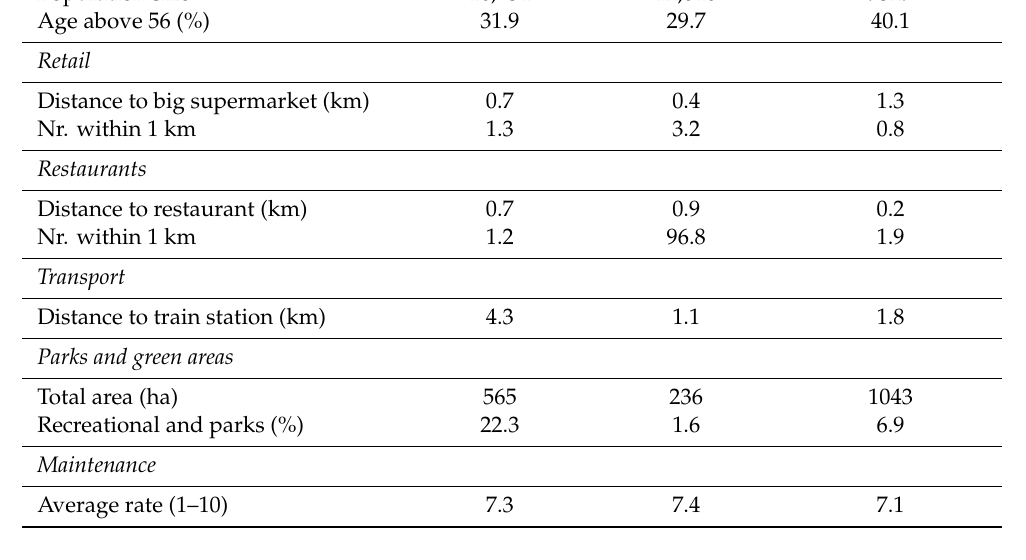
Table 1. Neighborhood characteristics.